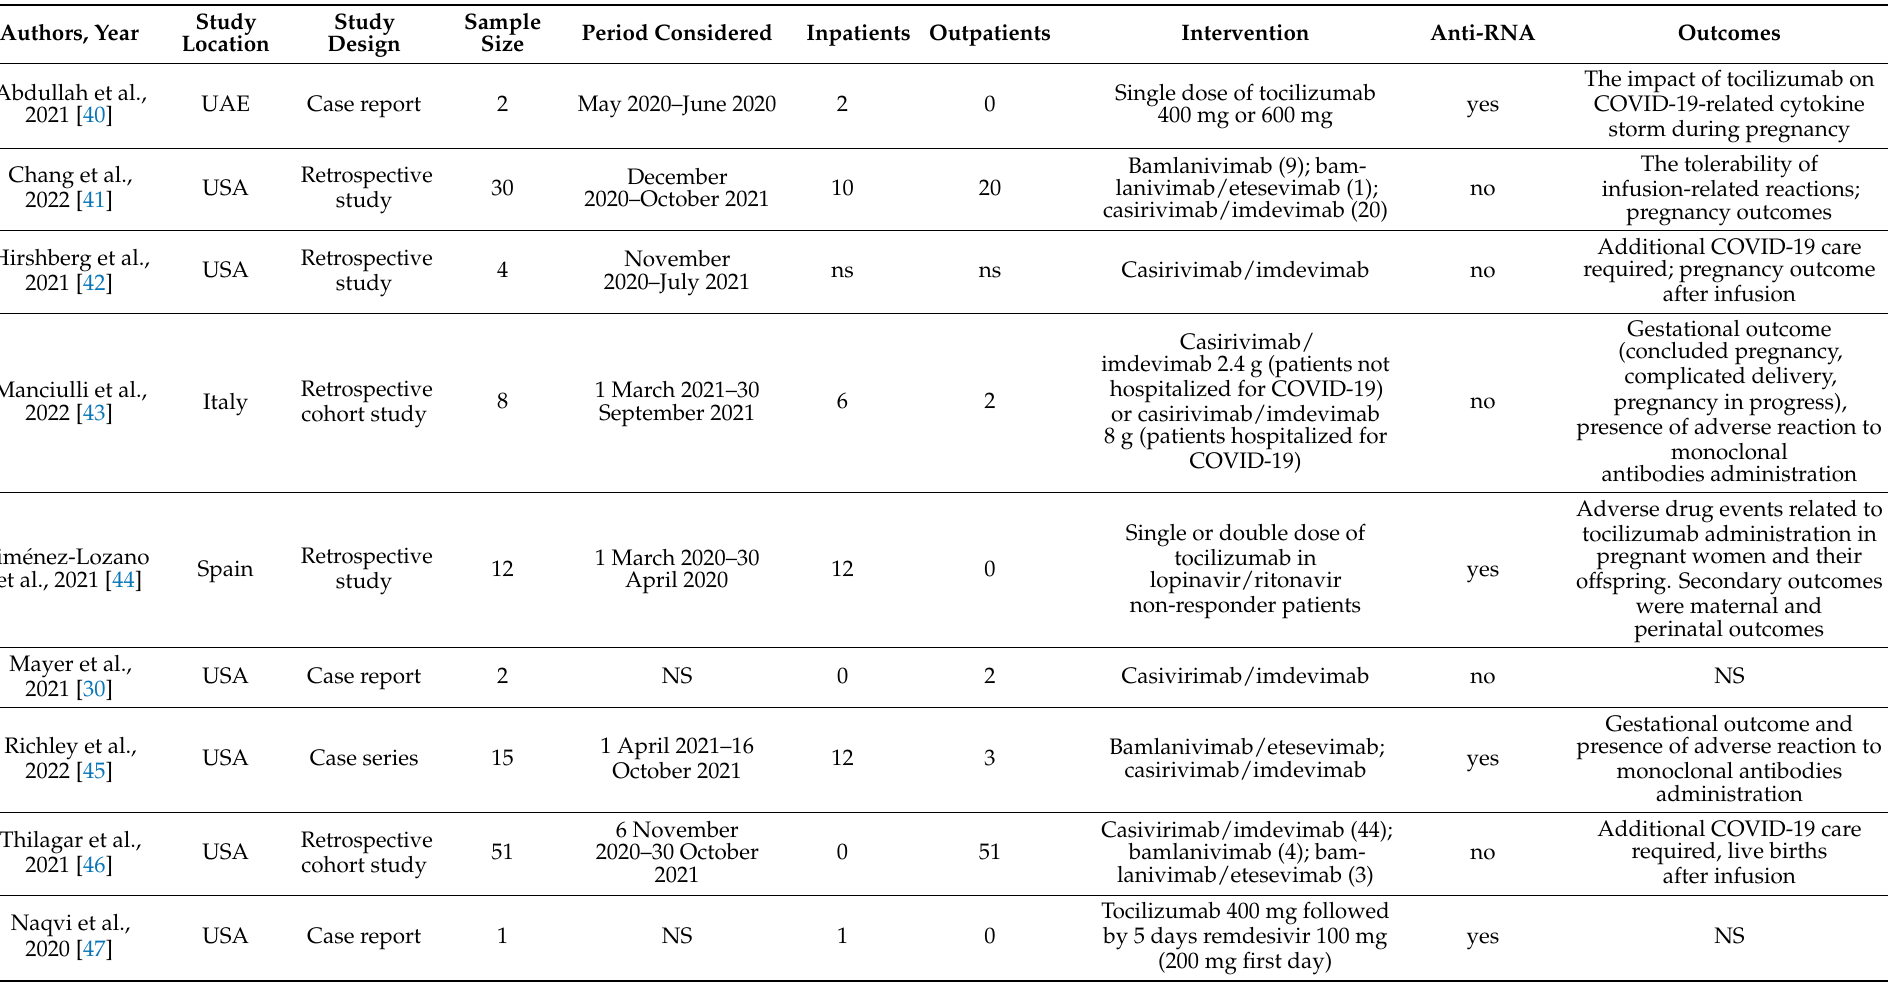
Table 1. General characteristics of included